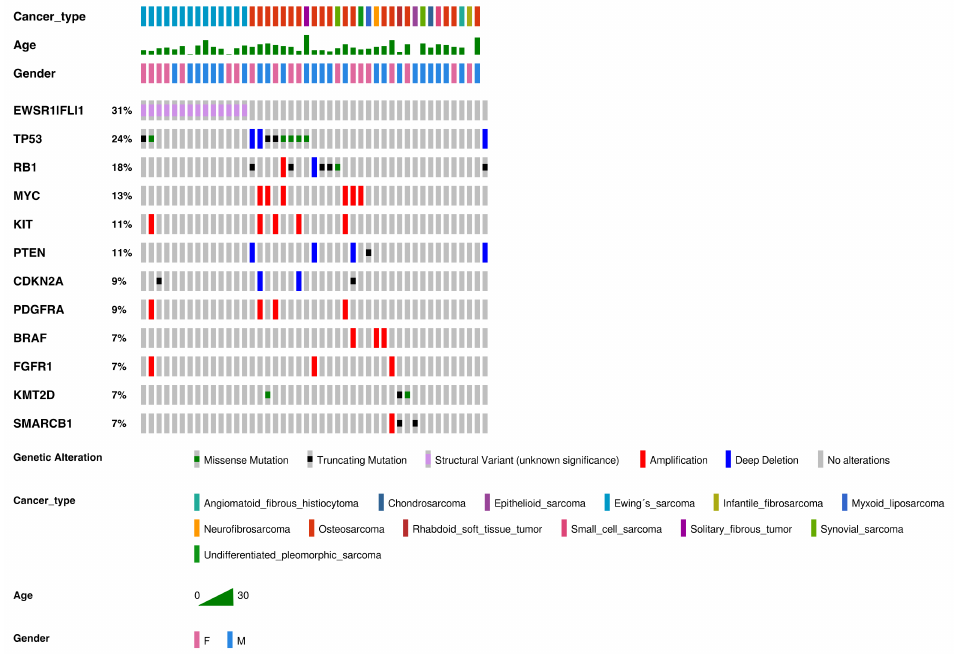
Figure 1. Genetic alterations detected in our cohort of sarcomas (in order of frequency). Genetic alterations, SNVs, indels, and fusions with a frequency ≥ 7% or three samples. Altered genes identified in two or fewer sarcoma samples were: ABL2, ACVR1, ARID1A, ARID1B, ASXL1, ATRX, CCND1, CDK4, CDK6, CHD7, CIC, DICER1, ERBB3, FGFR3, GLI1, JAK1, JAK2, IDH1, IGF1R, KDM6A, MET, MYCN, NF1, NF2, NOTCH1, PHF6, PIK3CA, SUZ12, SMARCA4, TCF3, TSC2, WT1, and rearrangements involving AGK-BRAF, ARID1B-MIR-4466, BCOR-CCNB3, EGFR-EGFR, ETV6-NTRK3, EWSR1-CREB1, FGFR2-KIAA1217, FUS-DDIT3, HMGA2-LPP, KMT2C-PRKAG2, NAB2-STAT6, RUNX1-MRPS6, SFPQ-EPS15, SS18-SSX2, SS18-SSX4, TMEM178B-BRAF, ZFP36-FOSB, and ZC3HAV1-BRAF